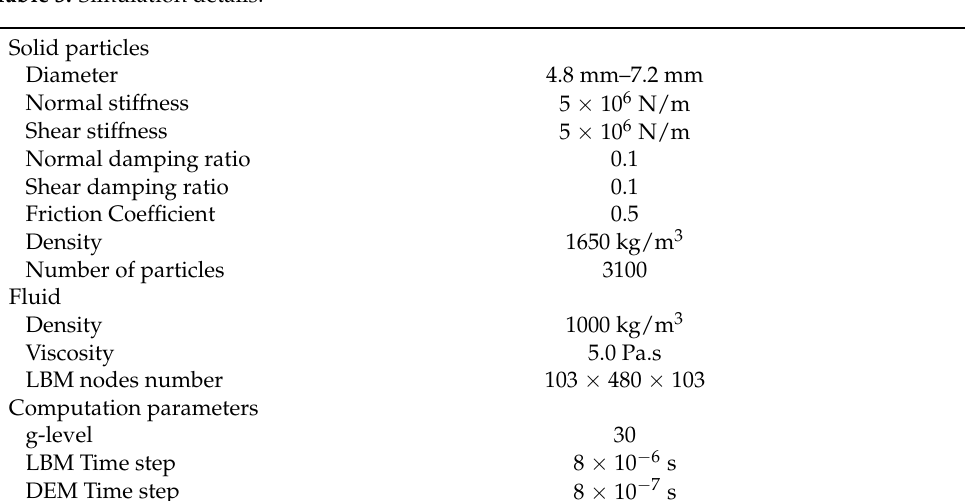
Table 3. Simulation